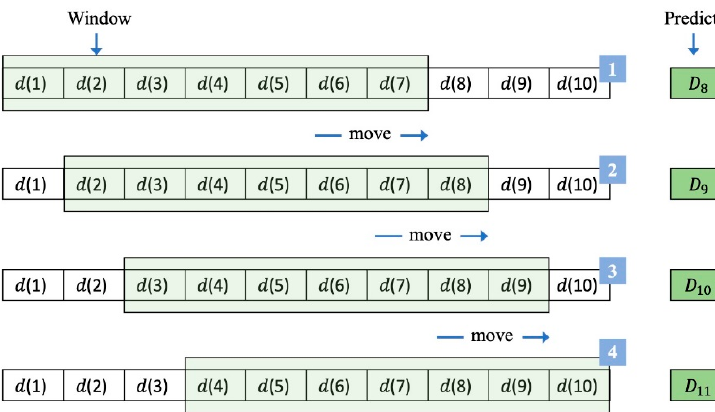
Figure 8. Sliding window of the β ‐ Sutte indicator. Table 7. The prediction results of the time series and ensemble models in two regions.